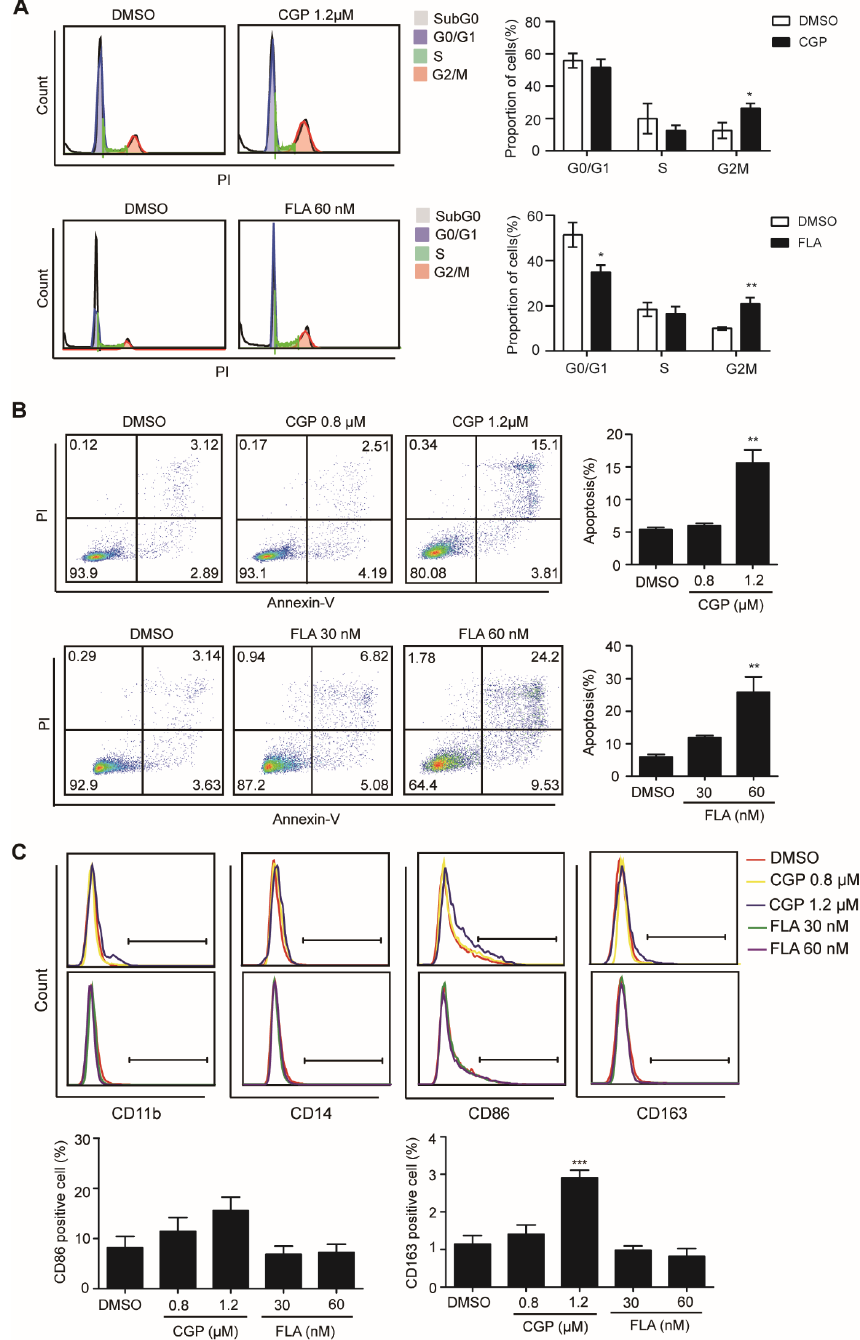
Figure 5. CDK1 inhibitors CGP and FLA can cause cell cycle arrest, apoptosis, and differentiation markers’ expression of OCI-AML3 cells. Flow cytometric analysis on cell cycle ( A ), apoptosis ( B ), and differentiation ( C ) of OCI-AML3 cells after treatment with CGP, FLA, or DMSO as indicated. The cell cycle analysis was conducted after treatment with CGP and FLA for 4 and 18 h, respectively. The apoptosis analysis was conducted after treatment with CGP or FLA for 24 h. CD11b, CD14, CD86, and CD163 were detected after treatment with CGP or FLA for 48 h. Data are presented as mean ± SD, * p < 0.05, ** p < 0.01, *** p <